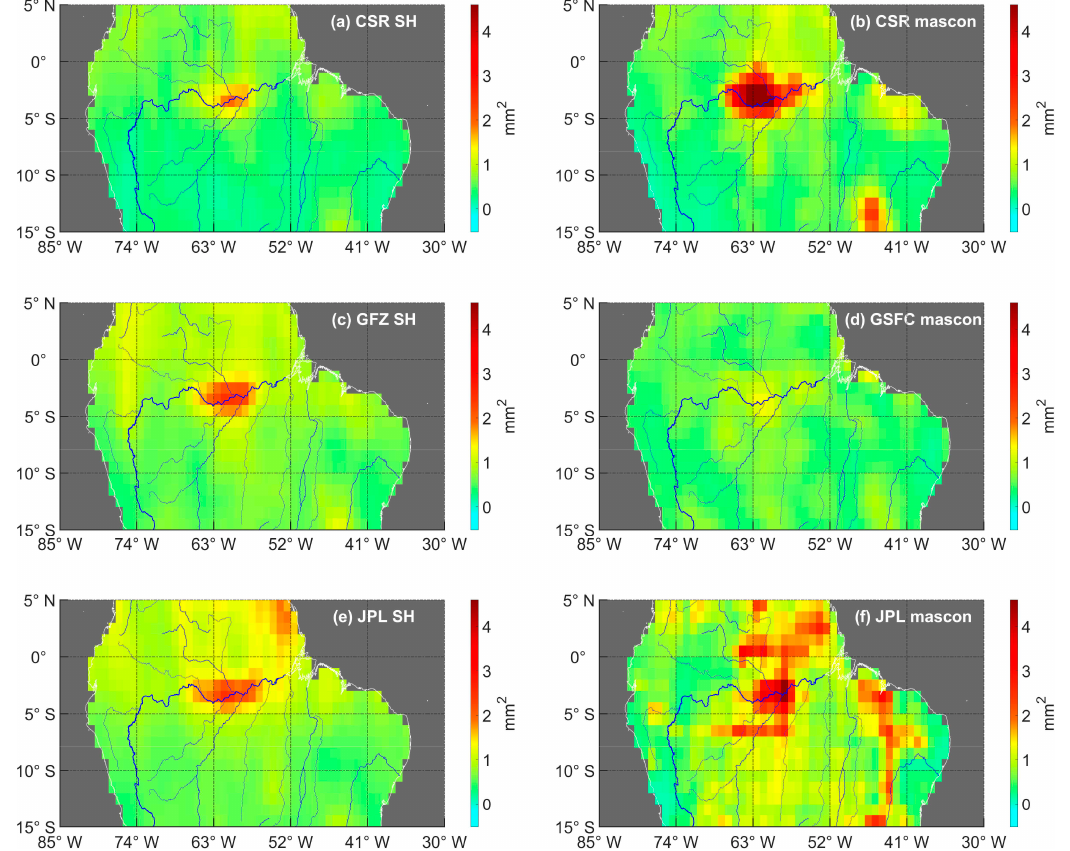
Figure 6. The variances of the noises of the vertical deformation estimated using the TCH method, derived from the 6 GRACE/GRACE-FO products provided by ( a ) CSR SH, ( b ) CSR mascon, ( c ) GFZ SH, ( d ) GSFC mascon, ( e ) JPL SH, and ( f ) JPL mascon. The resolution of the gridded data is 1 ° × 1 ° .